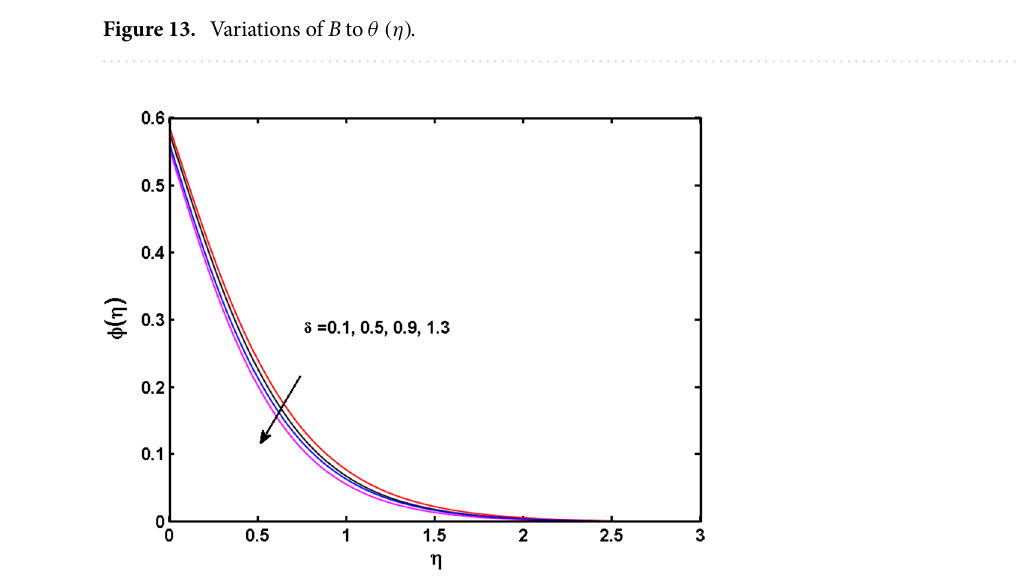
Figure 14. Variations of δ to φ (η)